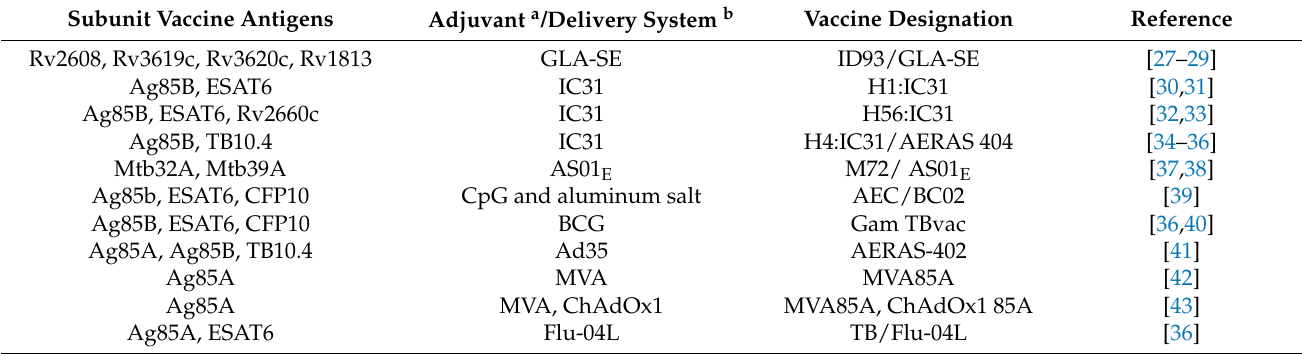
Table 1. Adjuvants and delivery systems used with subunit vaccines undergoing clinical trials in humans. Subunit Vaccine